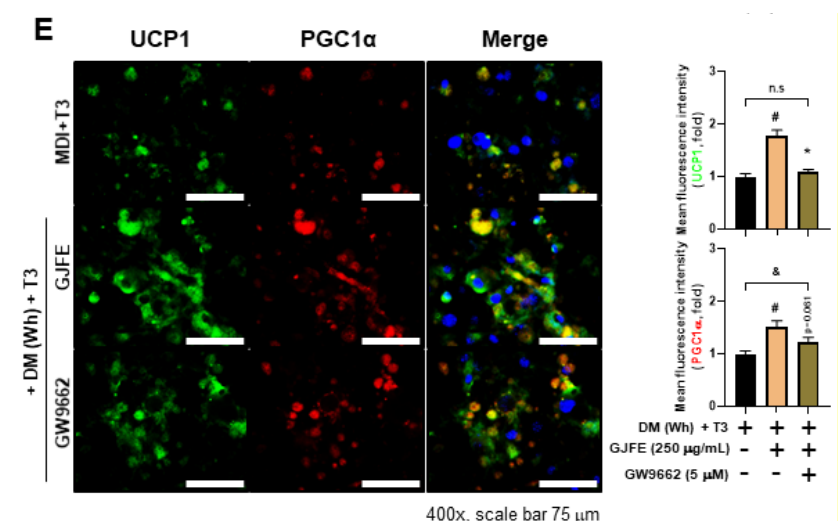
Figure 7. Role of PPAR γ in GJFE-induced thermogenic action of 3T3-L1 adipocytes. ( A ) Cytotoxicity of GW9662 (0.13 to 1.0 µ M) was measured in 3T3-L1 cells. ( B ) Protein expression of PPAR γ in GW9662-treated cells was analyzed by Western blot analysis. ( C ) PPAR γ levels of GJFE (125 and 250 µ g/mL)-treated 3T3-L1 cells in the presence/absence of GW9662 (0.5 µ M) were analyzed by Western blot analysis. ( D ) Mitochondrial abundance was detected by MitoTracker Red staining (magnification 400×, scale bar 75 μm). ( E ) Protein expressions of UCP1 (green) and PGC1α (red) were detected by immunofluorescence staining (magnification 400 × , scale bar 75 µ m). β -actin was used as a loading control for Western blot analysis. All data are expressed as the mean ± SEM of the data from three or more separate experiments. # p < 0.05 vs. DM (Wh) + T3-untreated 3T3-L1 cells, * p < 0.05 vs. MDI + T3-treated 3T3-L1 cells, $ p < 0.05 vs. DM (Wh) + T3 + GJFE, & p < 0.05 vs.